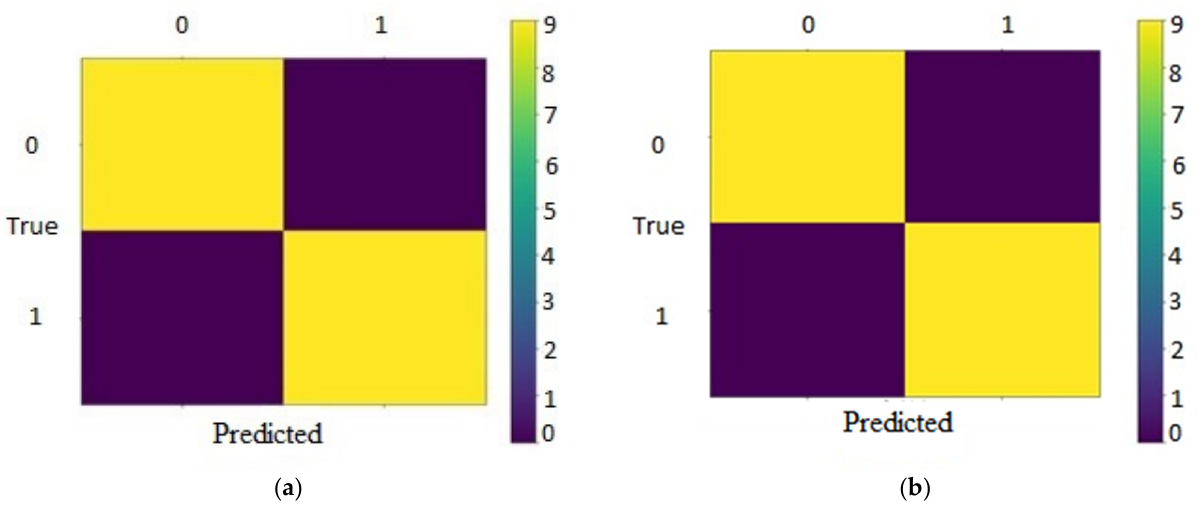
Figure 5. Our proposed method, confusion matrix of cross and independent dataset , ( a ) Cross validation DL-acc4C and ( b ) independent validation DL-acc4C.